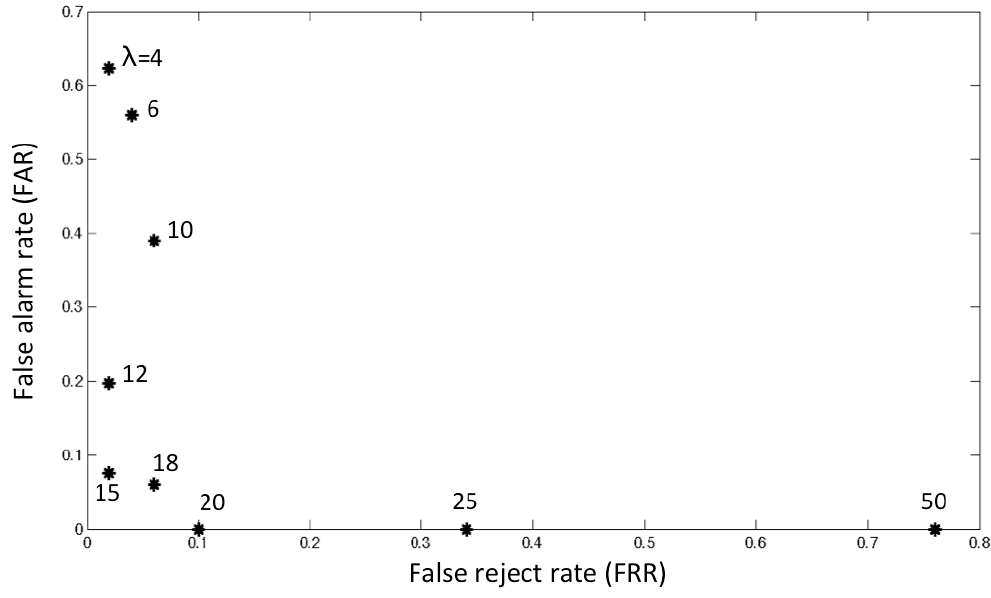
Figure 10. The ROC evaluation for different λ